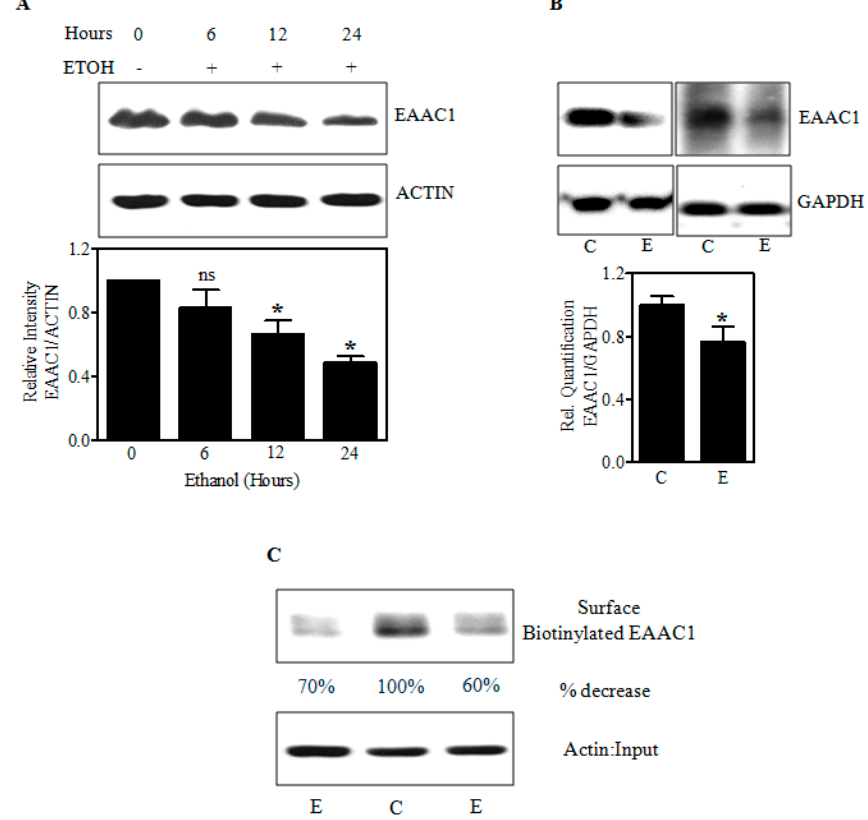
Figure 4. Effect of ethanol on the cellular and surface expression of the EAAC1 protein. Immunoblot analysis for EAAC1 and ACTIN or glyceraldehydes-3-phosphate dehydrogenase (GAPDH) in Control and E-treated PCNs ( n = 4) ( A ); in fetal brain cortices obtained from in utero iso-caloric dextrose or alcohol-exposed pregnant dams ( n = 6) ( B ); Biotinylation of cell surface proteins from control and E-exposed PCNs was processed for biotinylation assay as in Materials and Methods. Biotinylated cell surface EAAC1 and the corresponding unbiotinylated intracellular Actin were analyzed by Western blot with indicated antibodies ( C ); For C, the percentage decrease is obtained from control cells with n = 2 pooled from 3 individual samples. * p < 0.05 was considered significant for ethanol